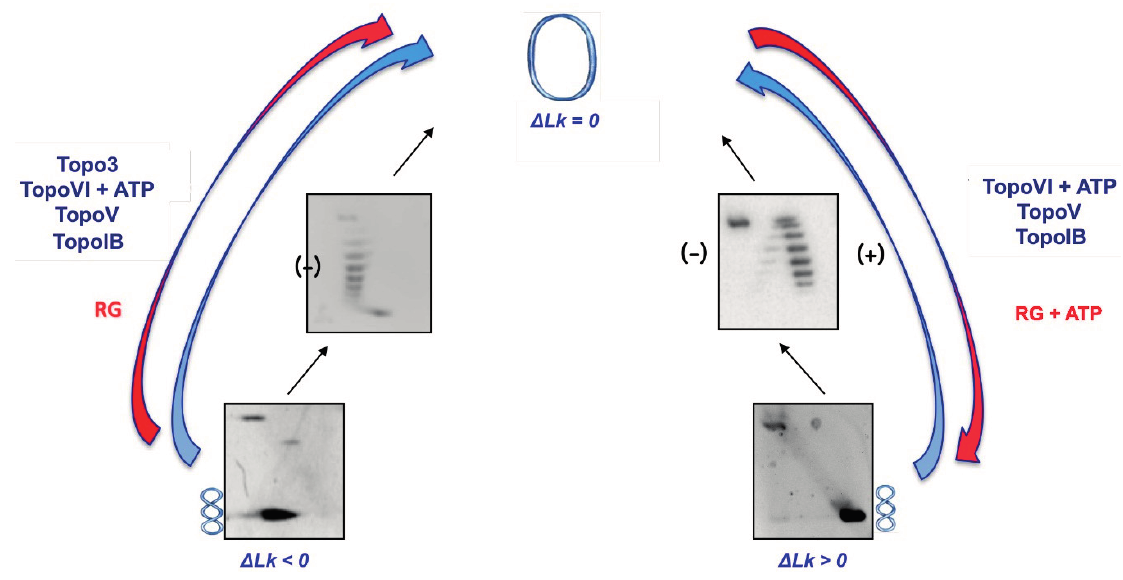
Figure 3. Activities of DNA topoisomerases of hyperthermophilic archaea on circular plasmids. The gels show typical migration of plasmid topological isomers: Δ Lk (Linking number) < 0 (negatively supercoiled); Δ Lk = 0 (relaxed); Δ Lk > 0 (positively supercoiled). Red arrows indicate the direction of activity of reverse gyrase (RG), which is always directed toward increasing linking number (from negative, to relaxed, to positive topoisomers). Blue arrows indicate the activity of all other topoisomerases, e.g., relaxation of either negative or positive topoisomers, with the exception of Topo3, which only relaxes negative